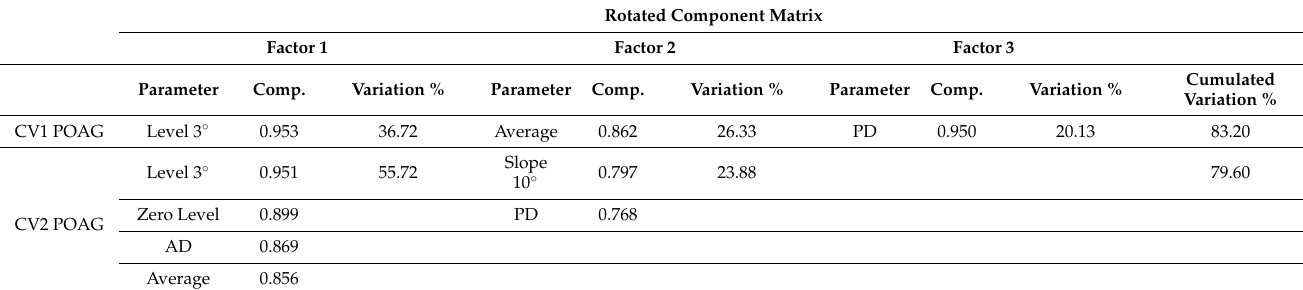
Table 12. Comparative distribution of the common factors of the “Visual field” indicators of patients with POAG at the first and second consultation (C1 and C2).